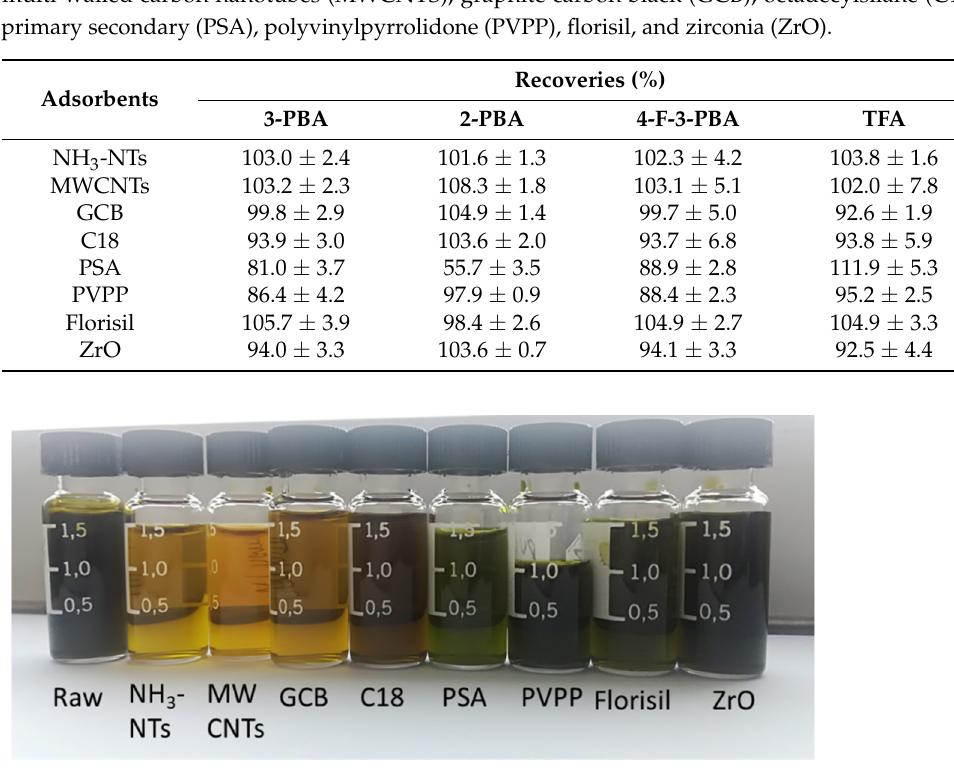
Figure 3. Recoveries of three analytes and internal substances with the extraction methods of origi- nal “quick, easy, cheap, effective, rugged and safe” (QuEChERS), CEN 15662, and AOAC 2007.1. Table 2. Recoveries of target compounds after clean-up by amino carbon nanotubes (NH 3 -NTs), multi-walled carbon nanotubes (MWCNTS), graphite carbon black (GCB), octadecylsilane (C18),